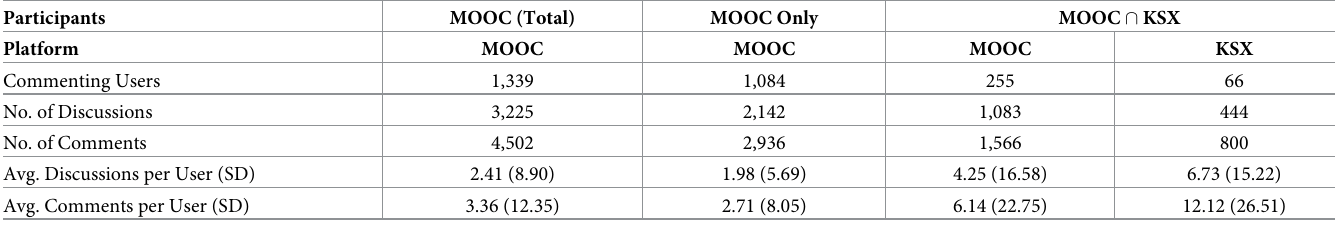
Table 3. MOOC and KSX forum